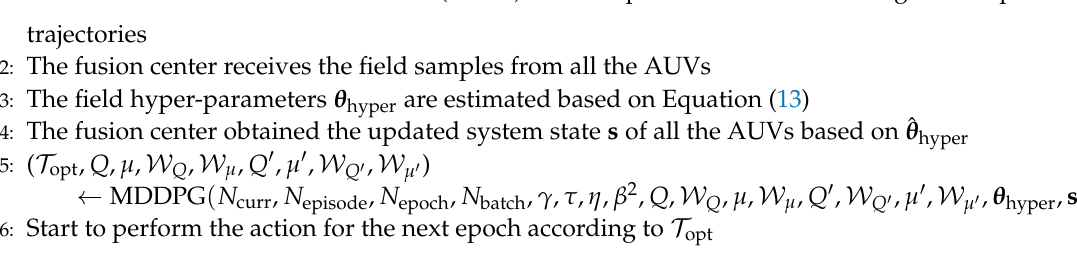
Algorithm 3 Online trajectory planning algorithm in each